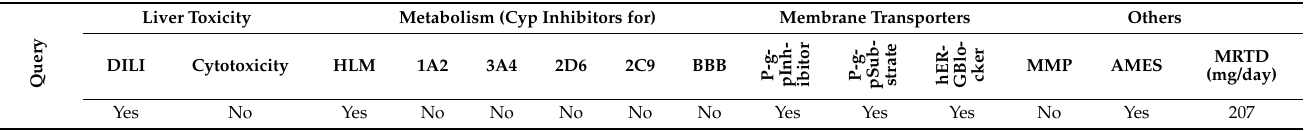
Table 6. The ADMET analysis results of asciminib show it to be hepatotoxic and negative for the AMES test.